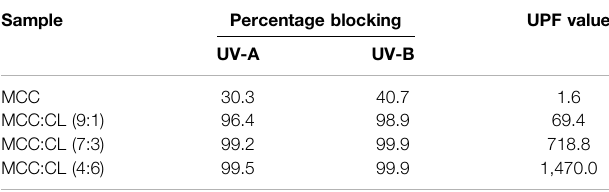
TABLE 2 | Percentage of blocking from UV-A, UV-B, and UPF values of the MCC fi lm and MCC:CL biocomposite fi lms. Sample